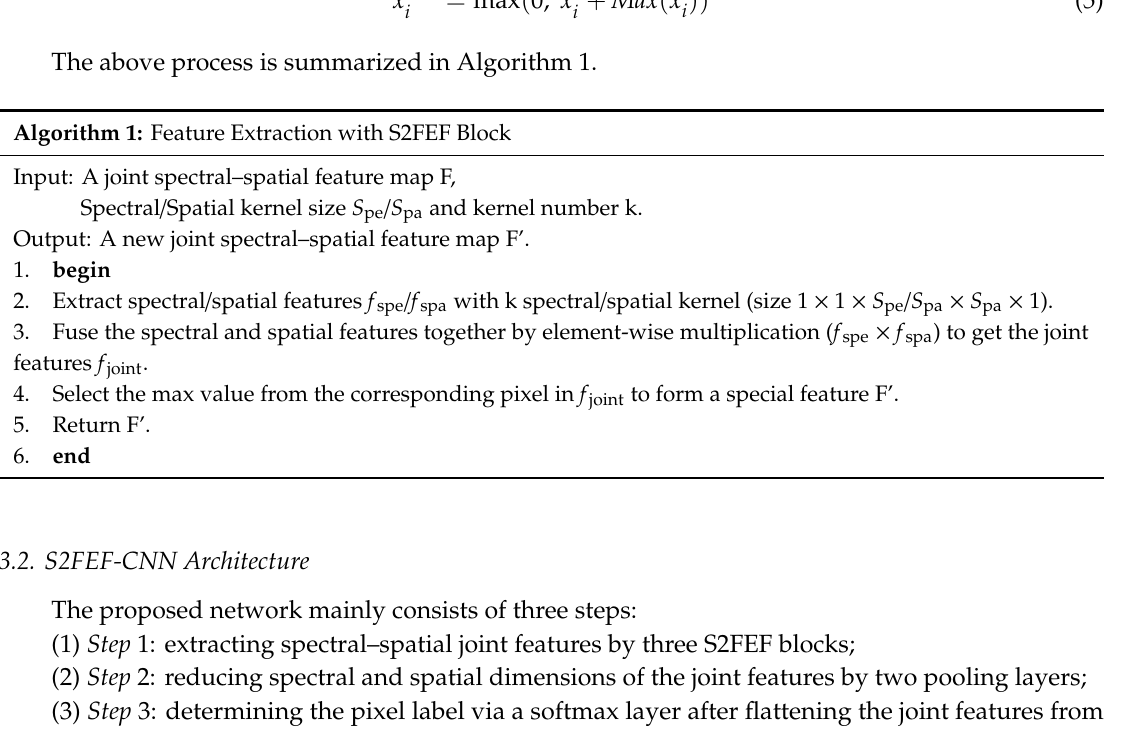
Algorithm 1: Feature Extraction with S2FEF Block